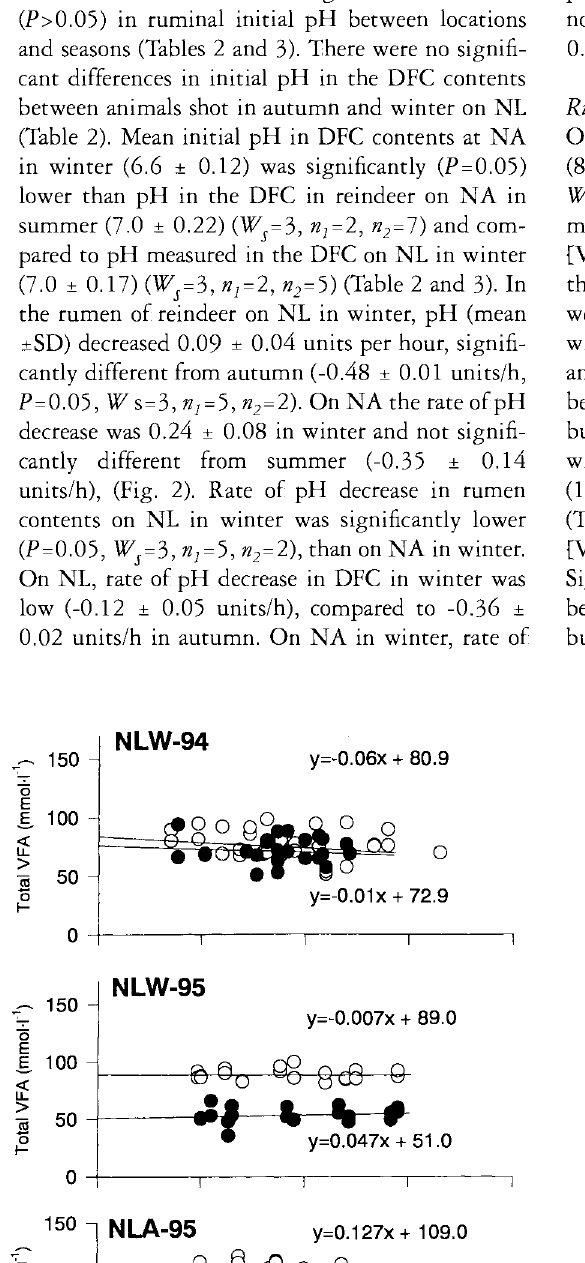
Fig. 3- Regression lines plot for the concentrations of the main volatile fatty acids in the rumen (O) and in the distal fermentation chamber (•) of Svalbard reindeer at Nordenskioldland (NL) and on Nordaustlandet (NA) different times of the year as a function of time. (W=winter.